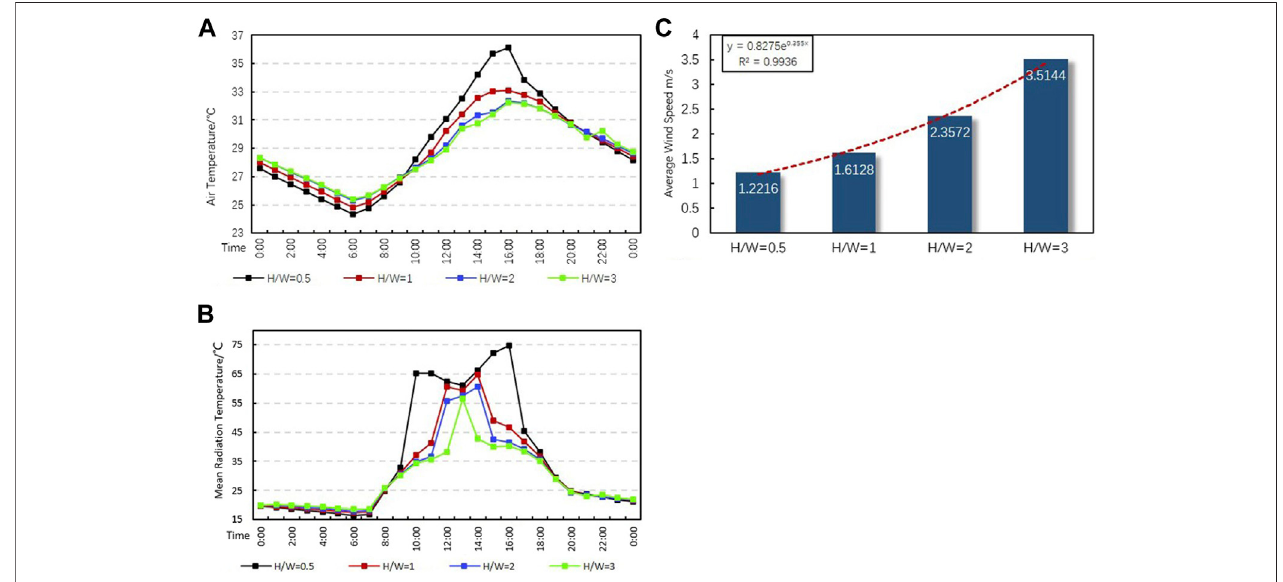
FIGURE 6 | Pro fi les of meteorological parameters in canyons with different aspect ratios-air temperature (A) , average wind speed (B) and mean radiation temperature (C) .